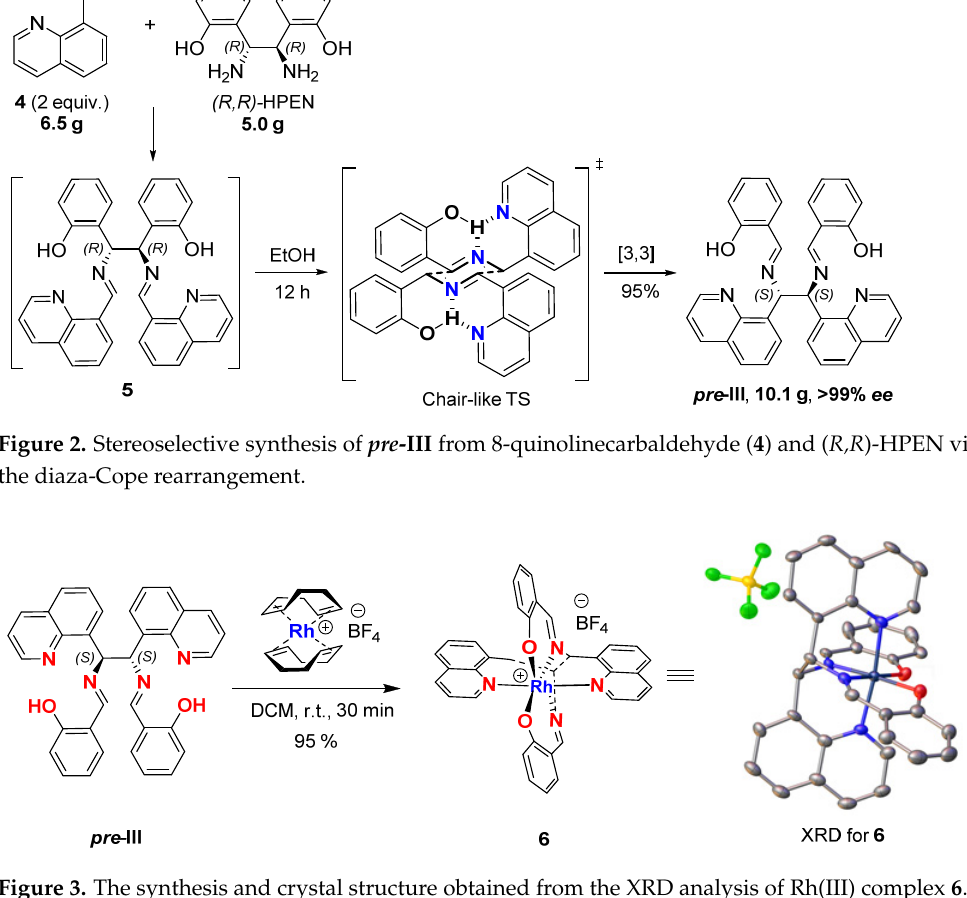
Figure 2. Stereoselective synthesis of pre -III from 8-quinolinecarbaldehyde ( 4 ) and ( R,R )-HPEN via the diaza-Cope rearrangement.